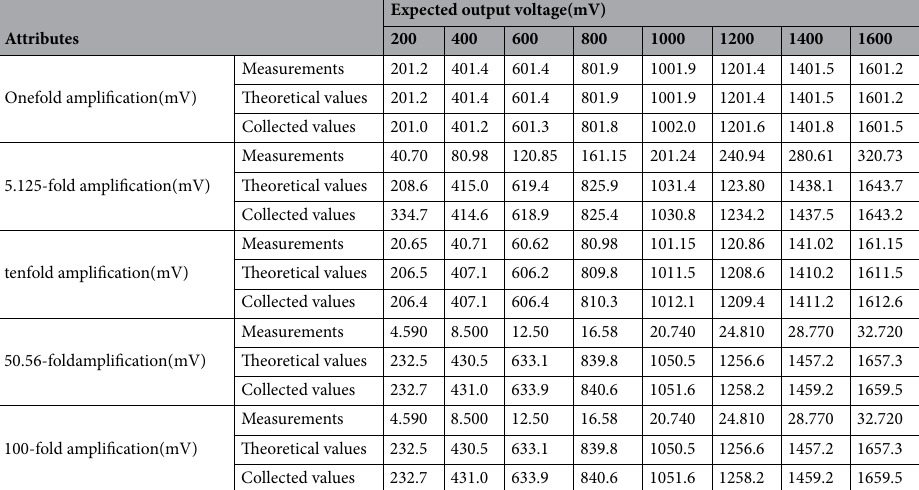
Table 4. Comparison of instrument measurement and board detection output